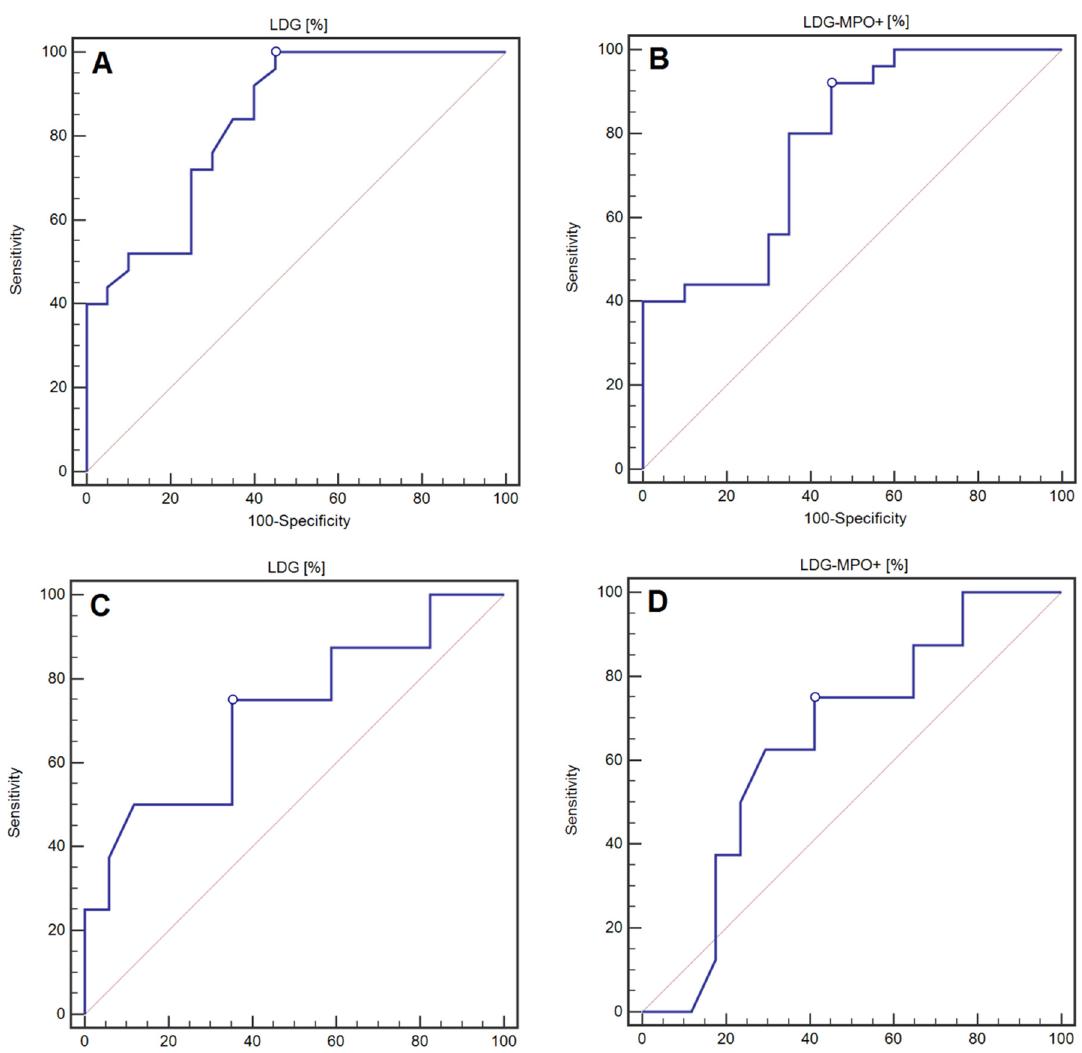
Figure 5. ROC curves representing the assessment of the diagnostic usefulness of the percentage of LDG ( A ) and the LDG fraction with the expression of MPO ( B ) in the detection of AIH. ROC curves representing the assessment of the diagnostic usefulness of the percentage of LDG ( C ) and the LDG fraction with the expression of MPO ( D ) in the detection of LC in the course of AIH.